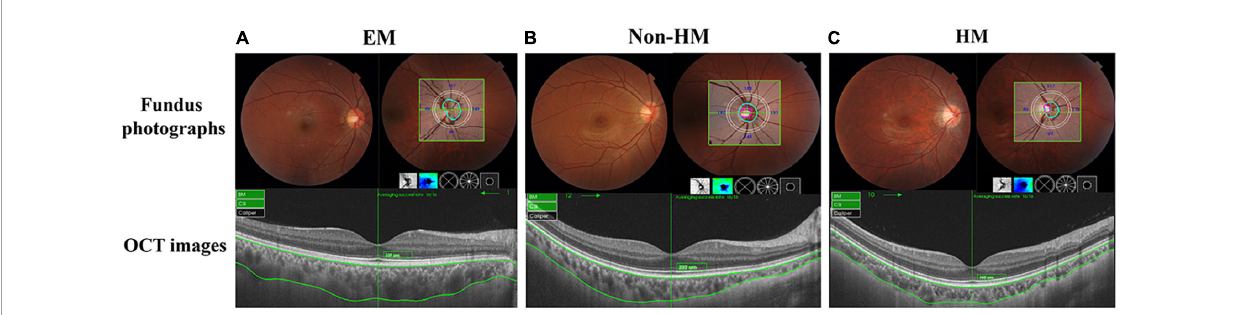
FIGURE1 Representative fundus photographs, optical coherence tomography (OCT) images, and thickness graph of EM (A) , non-HM (B) , and HM (C) groups. EM, emmetropia; HM, high myopia.